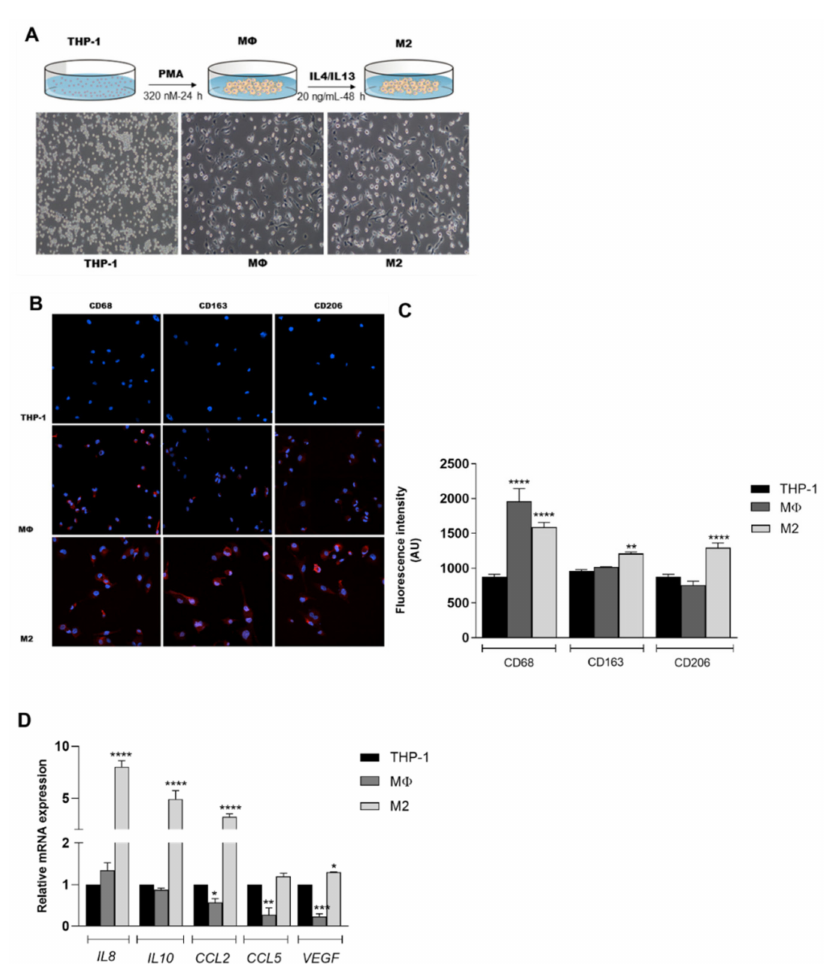
Figure 1. Di ff erentiation of THP-1 cells into macrophages. ( A ) Cell morphology and protocols used to obtain the M Φ and M2 macrophages. Magnification: 10 × ; ( B , C ) immunofluorescence images. CD68, CD163 and CD206 are stained in red. Nuclei are stained blue with Hoechst. Magnification: 20 × . A.U. arbitrary units; ( D ) mRNA levels of IL8, IL10, CCL2, CCL5 and VEGF . Data are reported as mean ± SD of three independent experiments performed in triplicate. * p < 0.05, ** p < 0.01, *** p < 0.001, **** p < 0.0001 vs. THP-1